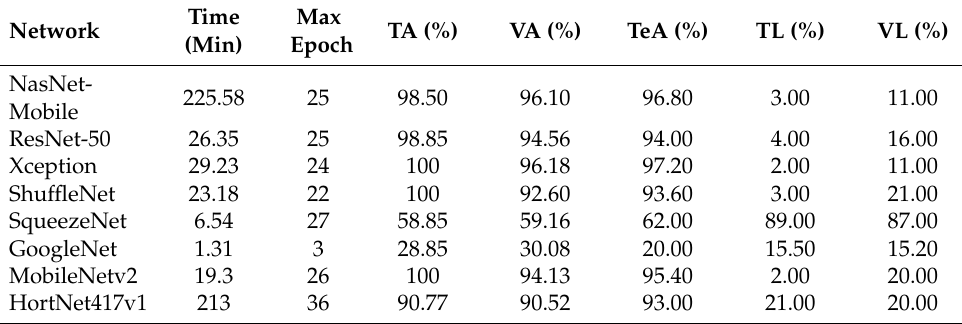
Table 3. Training performance (comparative